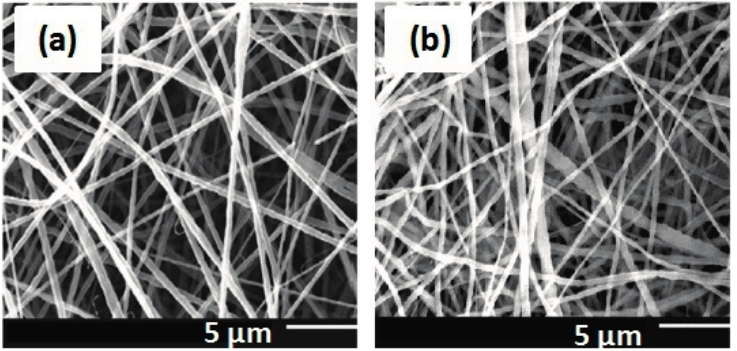
Figure 5. SEM images of zein/PEO/CS composite electrospun fibers with ( a ) and